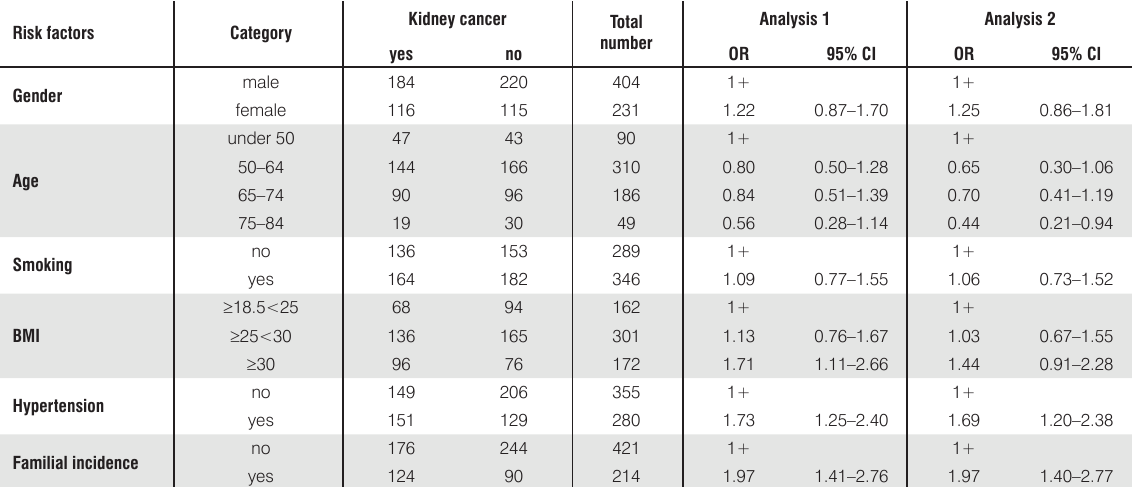
Table 1. Association between smoking, obesity, hypertension, familial incidence and the risk of the development of kidney cancer. Analysis 1 – age- and gender-adjusted OR; Analysis 2 – OR adjusted for age, gender, smoking, BMI, hypertension and familial